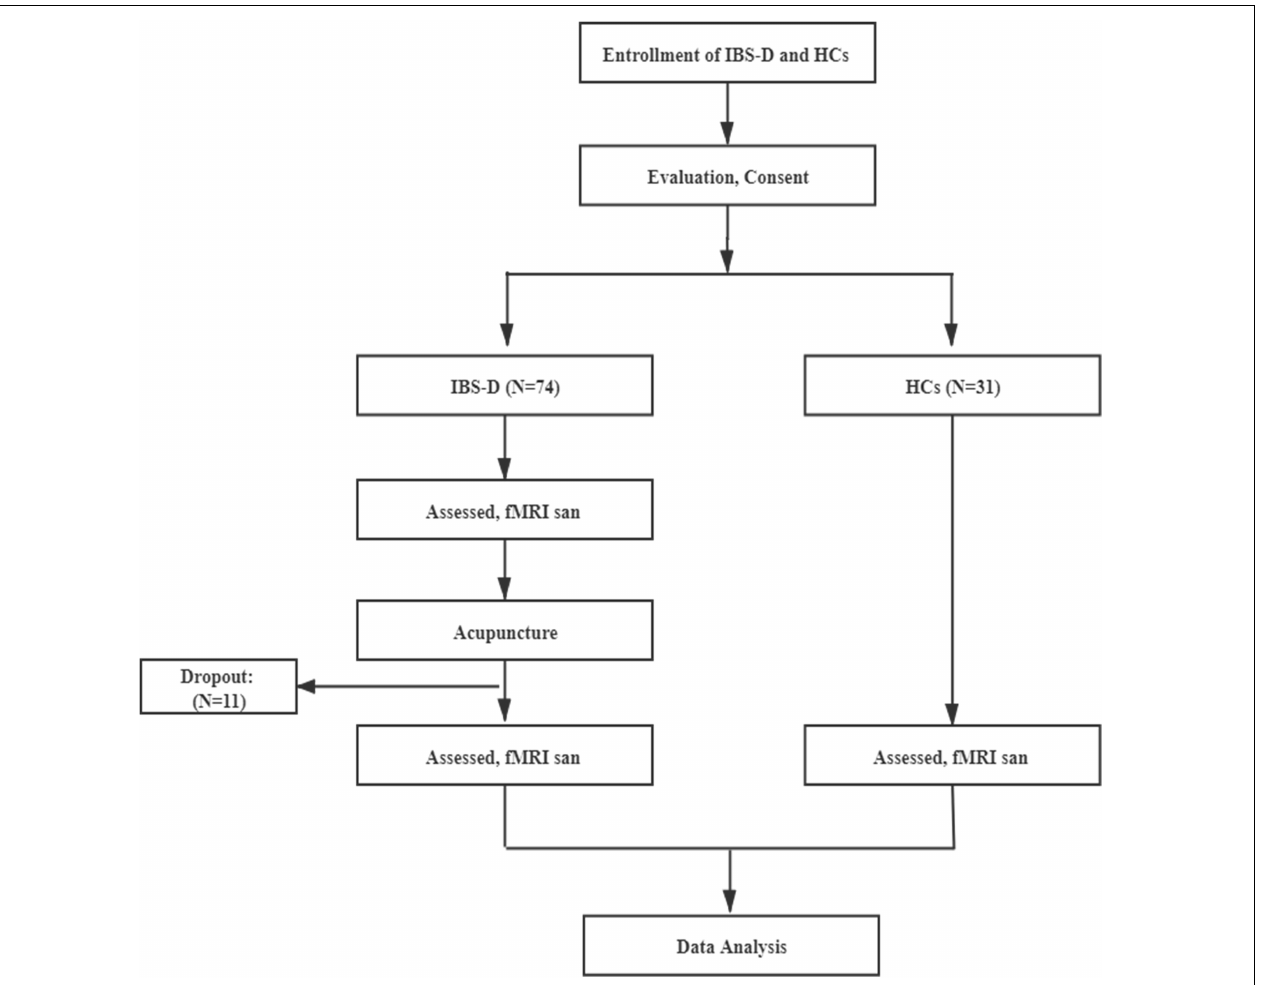
FIGURE 3 | Procedures and data used for the